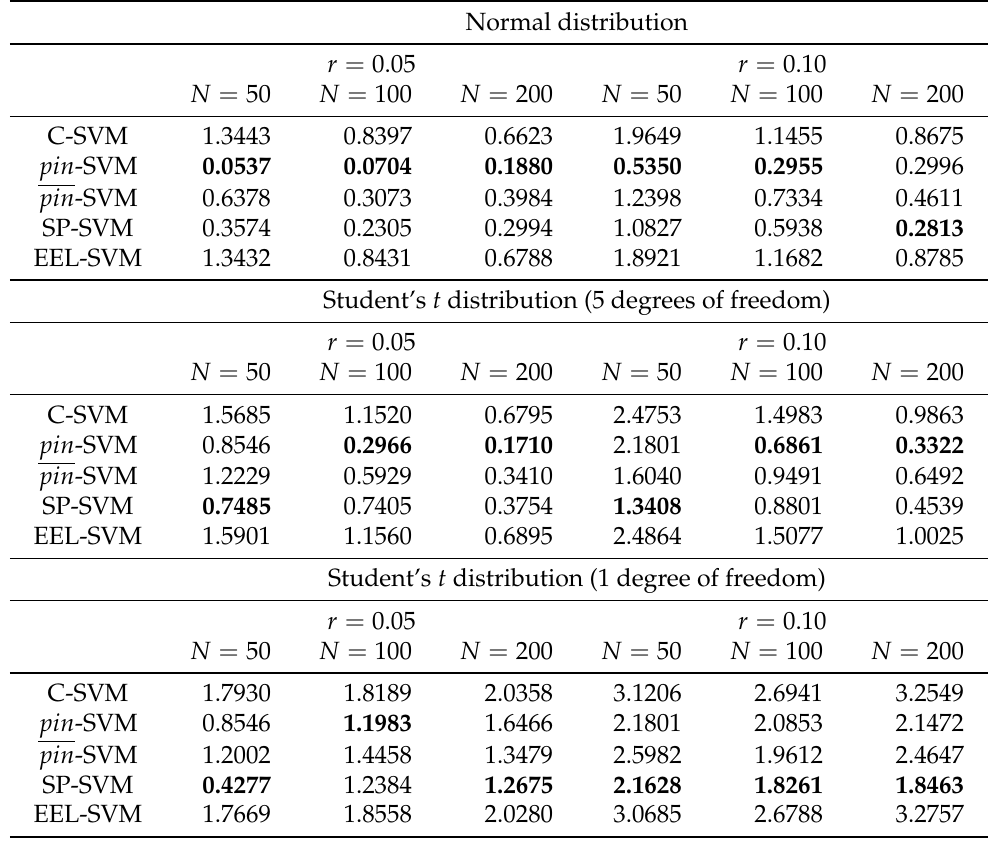
Table 2. Distance (13) between various SVM classifiers and Bayes classifier for contaminated synthetic data. Lowest distance along each row in bold.